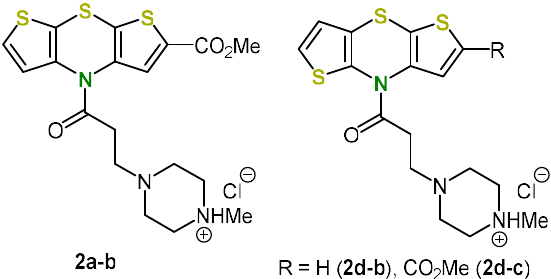
Figure 2. Syn - syn and anti - anti dithieno[1,4]thiazines 2a-b , 2d-b and 2d-c synthesized by Michael addition [32].